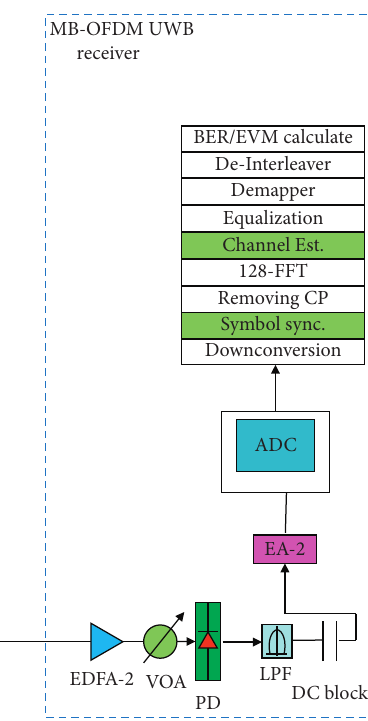
Figure 1: Simulation diagram of the MB-OFDM UWBoF transmission system based on a single training sequence